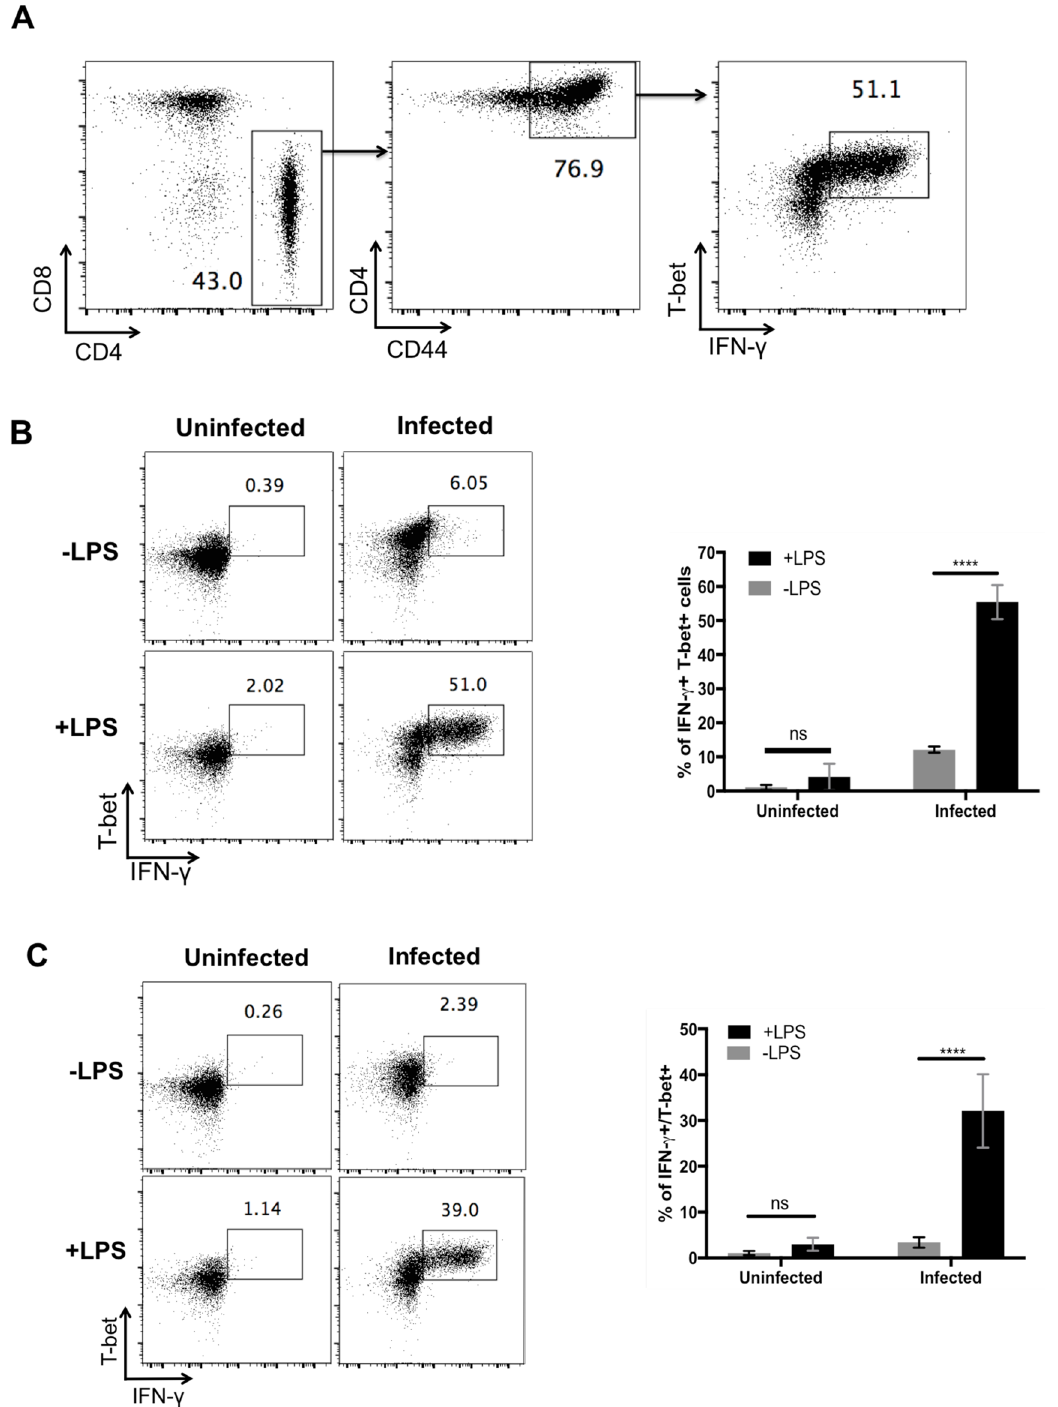
Fig 1. LPS induces Th1 cell IFN- γ production. C57BL/6mice were infected intravenously (i.v.) with 5 × 10 5 Salmonella Typhimurium or 1x10 7 Chlamydiamuridarum . Two weeks (Salmonella) , or one week (Chlamydia) later, infected or uninfectedmice were injected i.v. with 10ugLPS, and spleenswere collected4 hours later to determine IFN- γ production. (A) Gating strategy used for examiningIFN- γ productionby Th1 cells. Splenocytes were gated as live, singlet, and activated CD4 + CD8 - cells. This cell population was then examinedfor IFN- γ productionand T-bet expression. Representative flow cytometry plots and a graph from combineddata are shown for (B) Salmonella -infectedmice (B) and